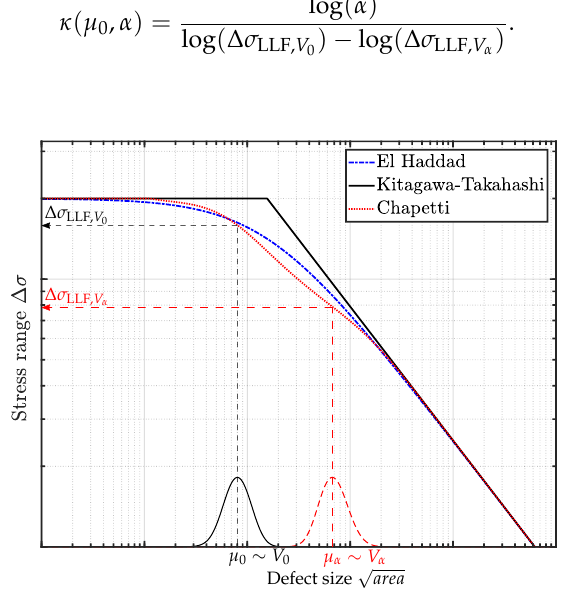
Figure 13. Schematic set up of the fatigue assessment model.